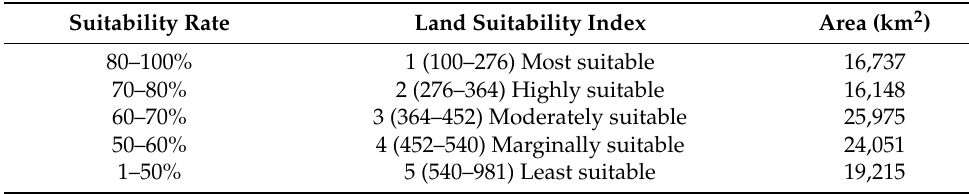
Table 14. Sensitivity analysis without climatic factors.